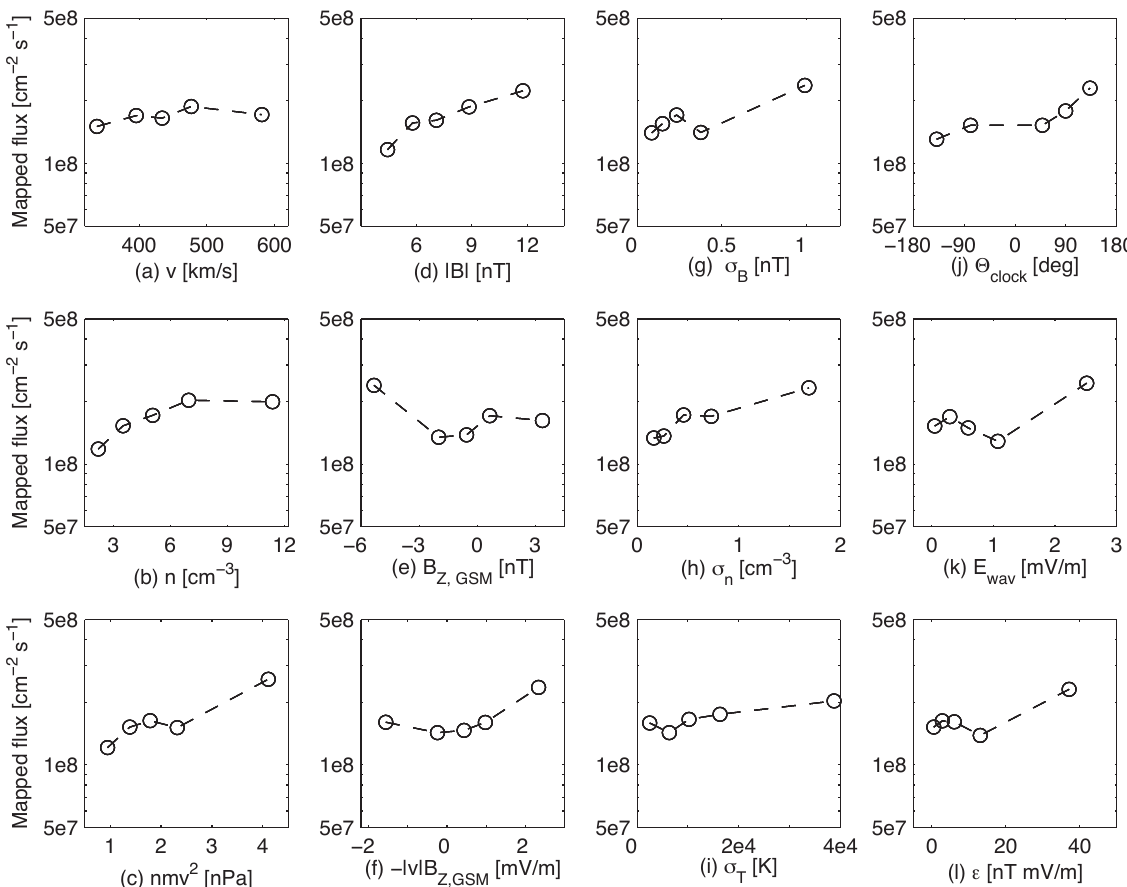
Fig. 11. Outflow dependence on different solar wind parameters. (a) Solar wind speed. (b) Solar wind density. (c) Solar wind dynamic pressure, nmv 2 . (d) Magnitude of interplanetary magnetic field (IMF). (e) IMF B Z, GSM . (f) Approximation of the y-component of the solar wind electric field, E y ≈−| v | B Z . (g–i) Standard deviation of the IMF, the solar wind density and temperature. (j) The IMF clock angle. GSM (k) The parameter E wav , which is a measure of the cross-polar cap potential. (l) The (cid:15) parameter of Perreault and Akasofu (1978). (The total flux data set consists of 180000